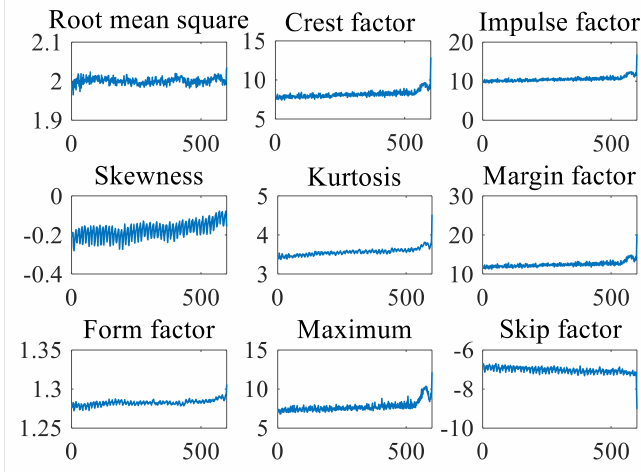
Figure 11. Features of the degradation process data